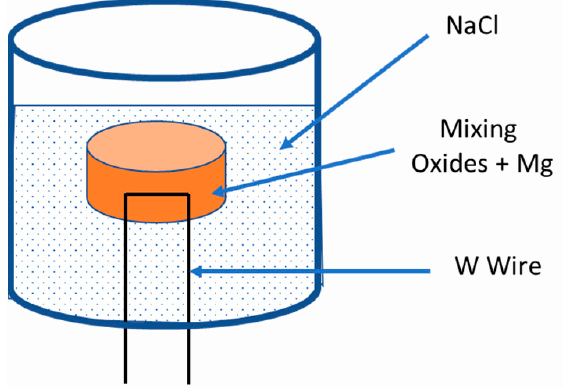
Figure 1. Scheme of the SHS reactor.